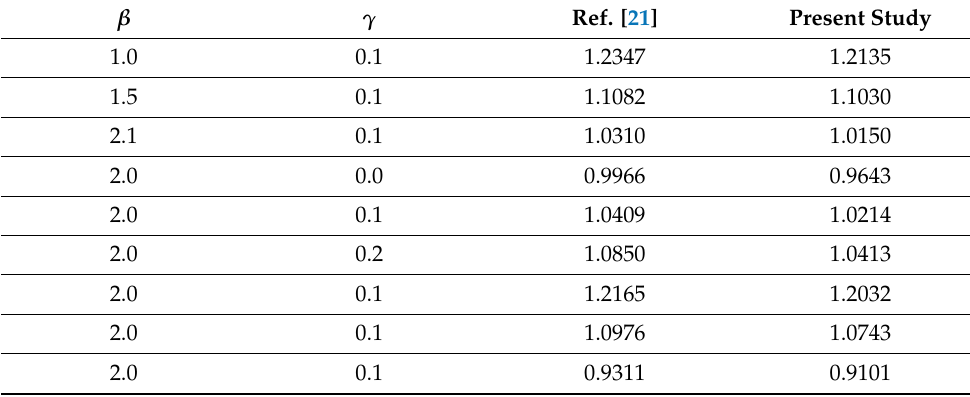
Table 12. Comparison of skin friction coefficient number with Ref. [21].